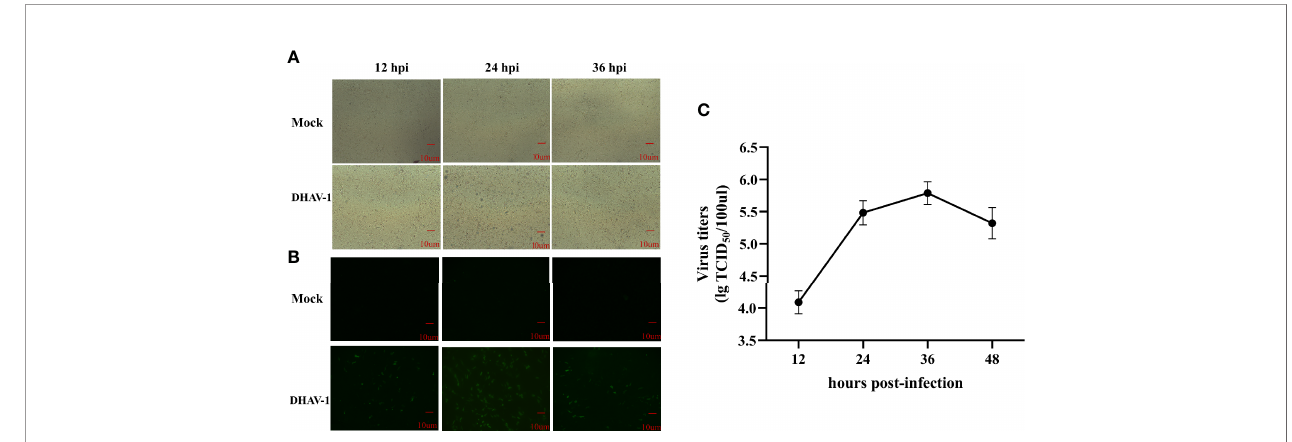
FIGURE 1 | Characteristics of DEFs following DHAV-1 infection. (A) Morphology of mock and DHAV-1-infected DEFs at 12 hpi, 24 hpi, and 36 hpi. (B) Fluorescent microscope images of LY0801 strain replication in DEFs at 12, 24, and 36 hpi. (C) The replication kinetic of LY0801 strain in DEFs. DEFs were infected with LY0801 strain (3 MOI) and virus titers were detected by TCID50